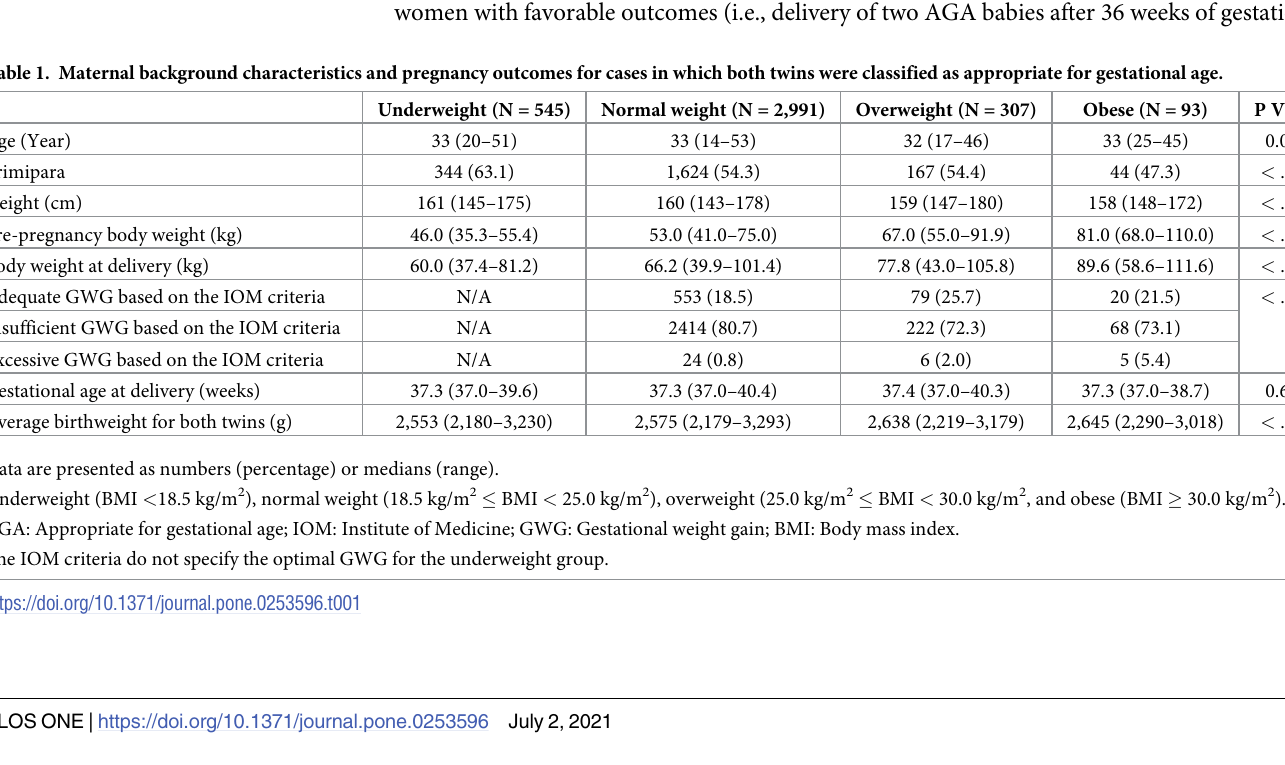
Table 2 shows the 25 th –75 th percentile for GWG for cases in each BMI category in which both babies were AGA. The GWG among the cases with favorable outcomes (i.e., delivery of two AGA babies after 36 weeks of gestation) ranged 11.5–16.5 kg, 10.3–16.0 kg, 6.9–14.7 kg, and 2.2–11.7 kg and the GWG among the cases delivered on or after 34 weeks of gestation ran- ged from 10.4–15.7 kg, 9.6–15.2 kg, 6.7–14.0 kg, and 1.2–10.4 kg in the underweight, normal weight (IOM criteria: 16.8–22.7 kg), overweight (IOM criteria: 14.1–22.7 kg), and obese (IOM criteria: 11.3–19.1 kg) groups, respectively. The optimal GWG tended to decrease as the BMI increased, and the ranges were much lower than those specified in the IOM criteria.